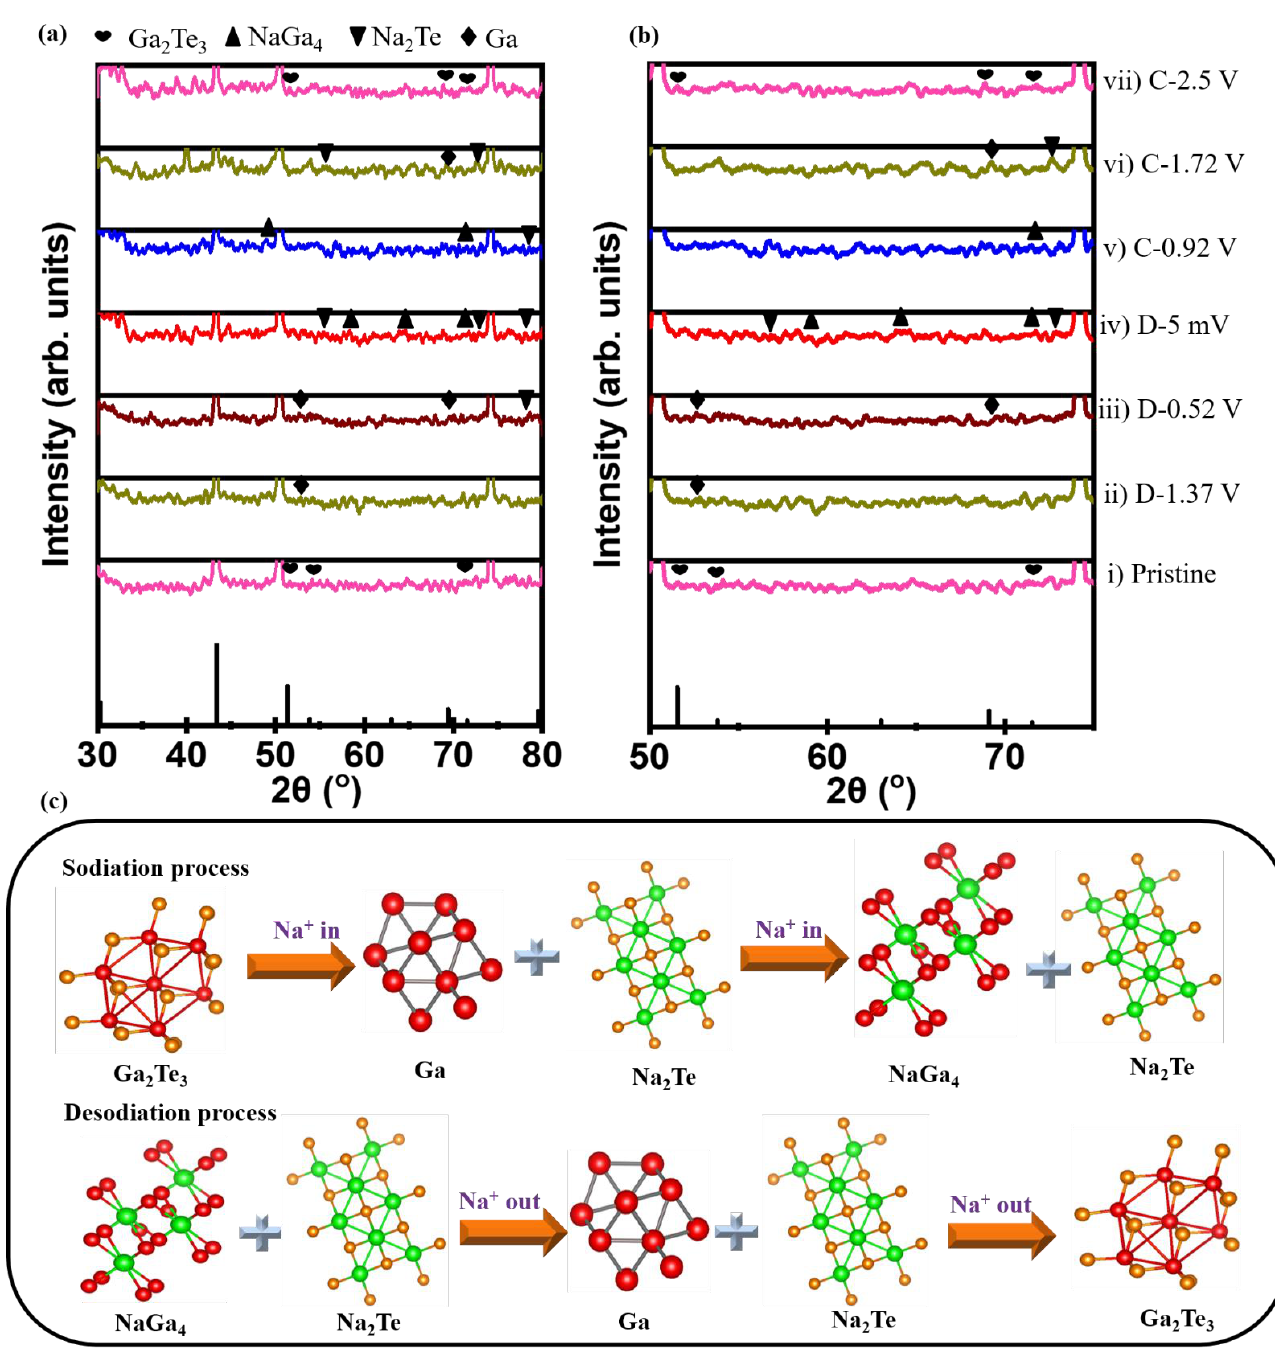
Figure 4. ( a , b ) Ex situ XRD patterns obtained at selected cutoff potentials in initial sodiation/desodiation process; ( c ) schematic of electrochemical reaction mechanism of Ga 2 Te 3 – TiO 2 – C(10%) electrode during cycling. For the first, fifth, and 20th cycles, the EIS profiles of the Ga 2 Te 3 – TiO 2 – C(10%), Ga 2 Te 3 – TiO 2 – C(20%), and Ga 2 Te 3 – TiO 2 – C(30%) electrodes were obtained (Figure 5). The charge-transfer resistance (R ct ), SEI layer resistance (R SEI ), interfacial double-layer capaci- tance (C dl ), Warburg impedance (Z w ), and constant phase element (C PE ). The R ct at the elec-